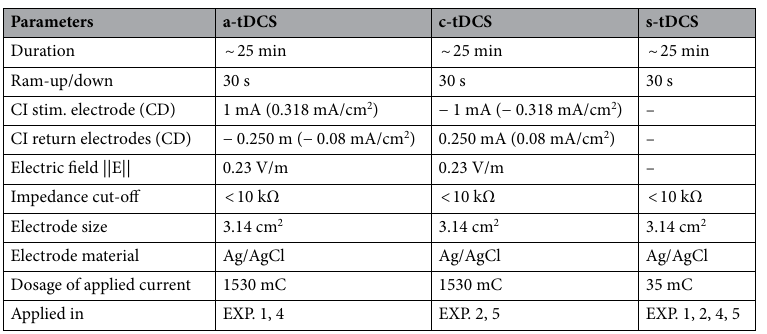
Table 4. tDCS parameters for four of the five experiments. CI = current intensity; CD = current